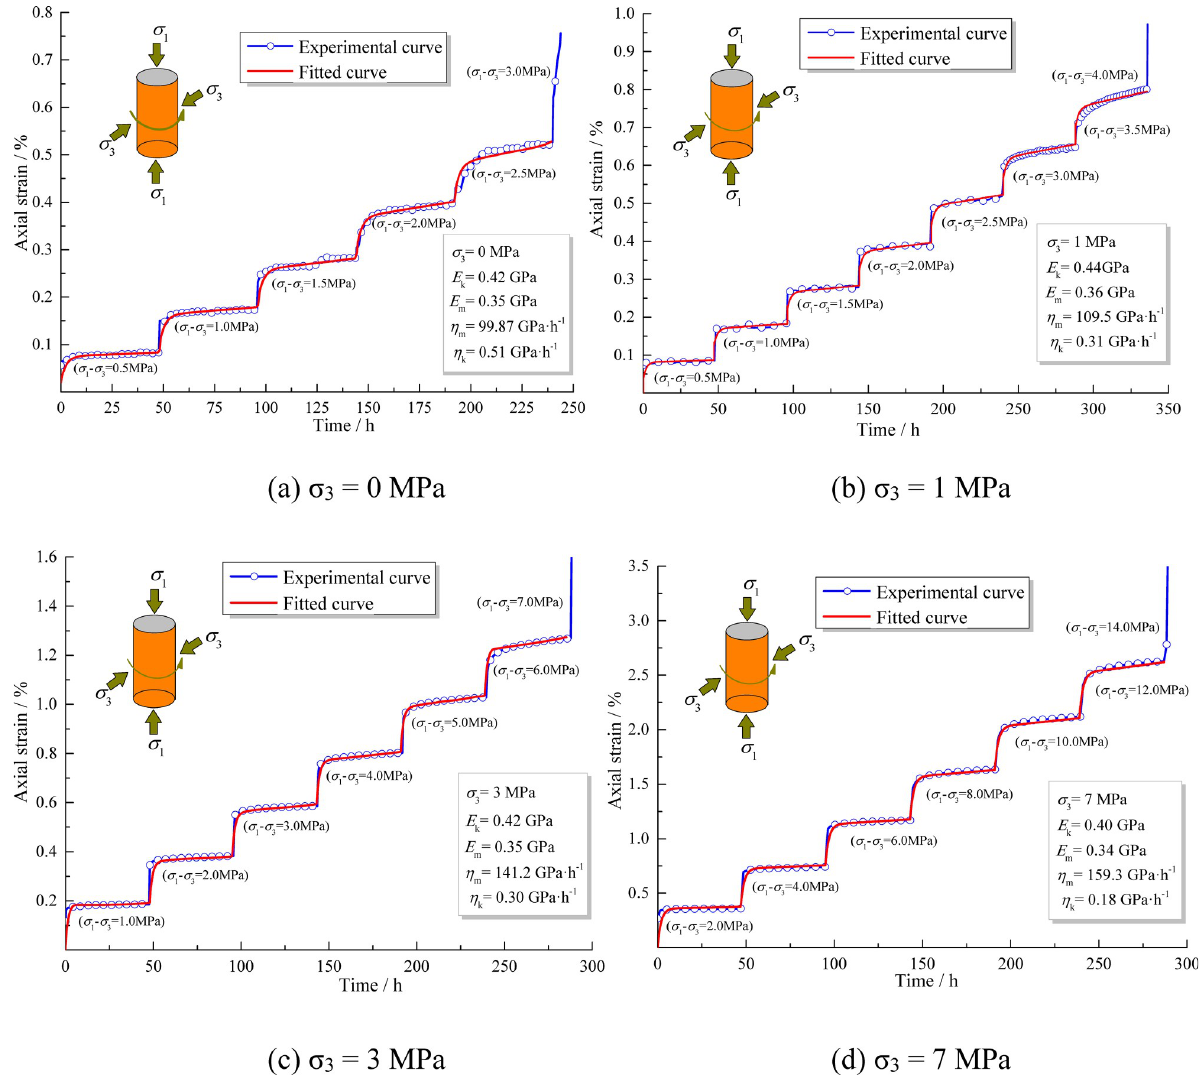
Fig 5. Creep curves and fitted curves of mudstone under different confining pressures. (a) σ 3 = 0 MPa (b) σ 3 = 1 MPa (c) σ 3 = 3 MPa(d) σ 3 = 7 MPa.